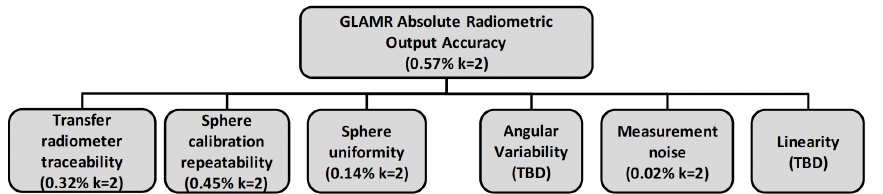
Figure 15. The proposed uncertainty budget of GLAMR RadCal on the entrance of a sensor under test. The values are representative of the values expected for the 400 to 950 nm spectral